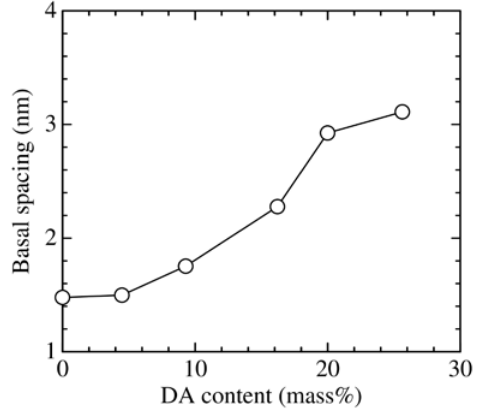
Figure 2. Change in basal spacing of samples with DA content.